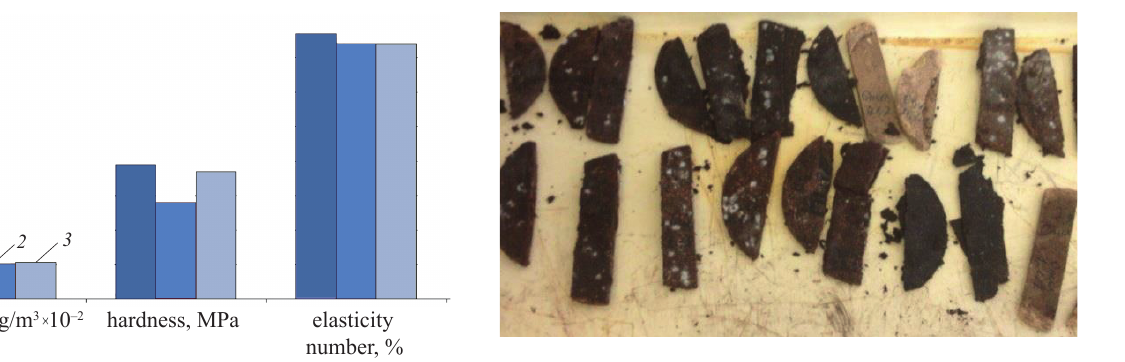
elastic modulus in flexure, MPa 10 –3